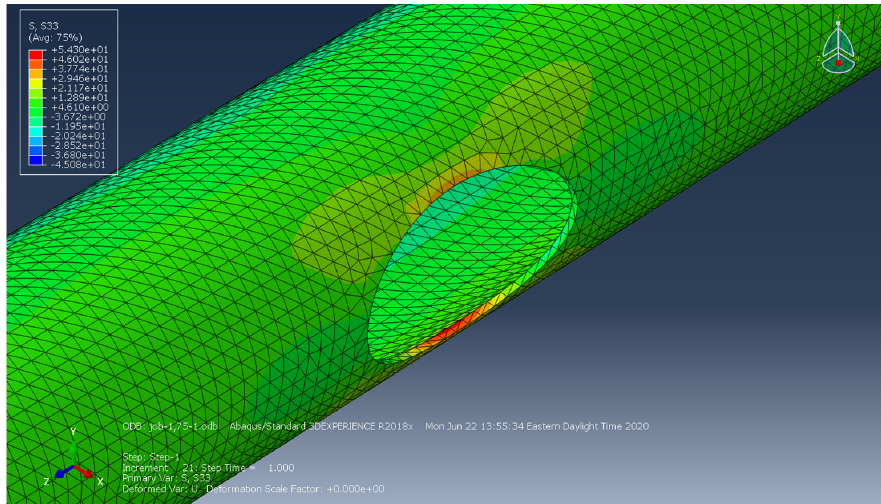
Figure 12. Aspect ratio 1.5-1 in longitudinal (Z) direction.